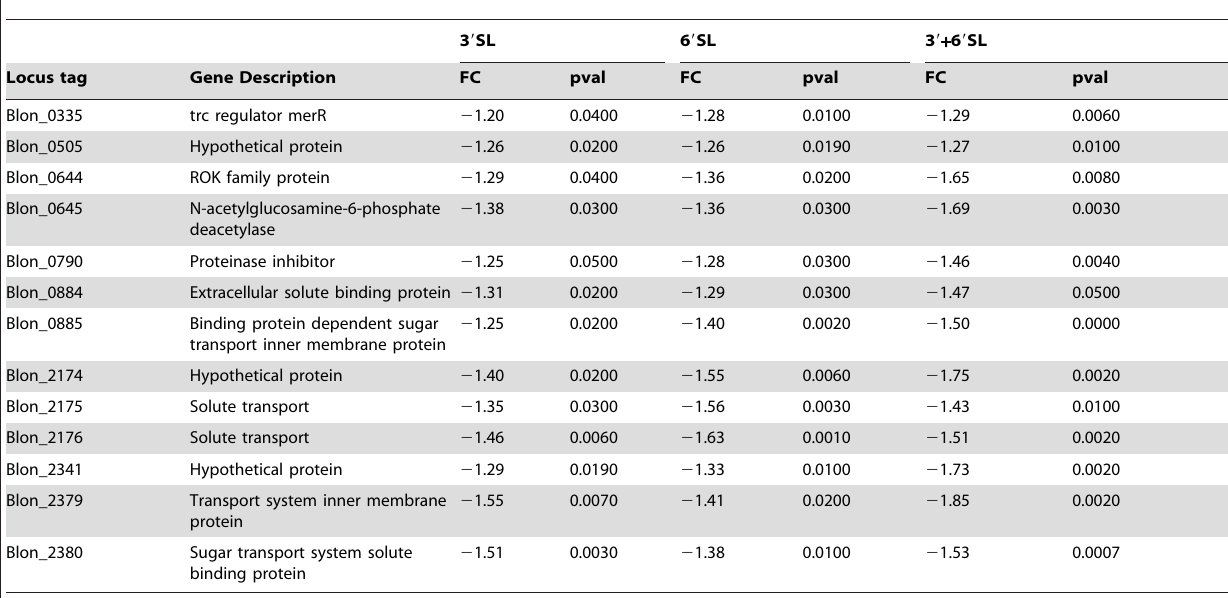
Table 3. Down-regulated genes common to all